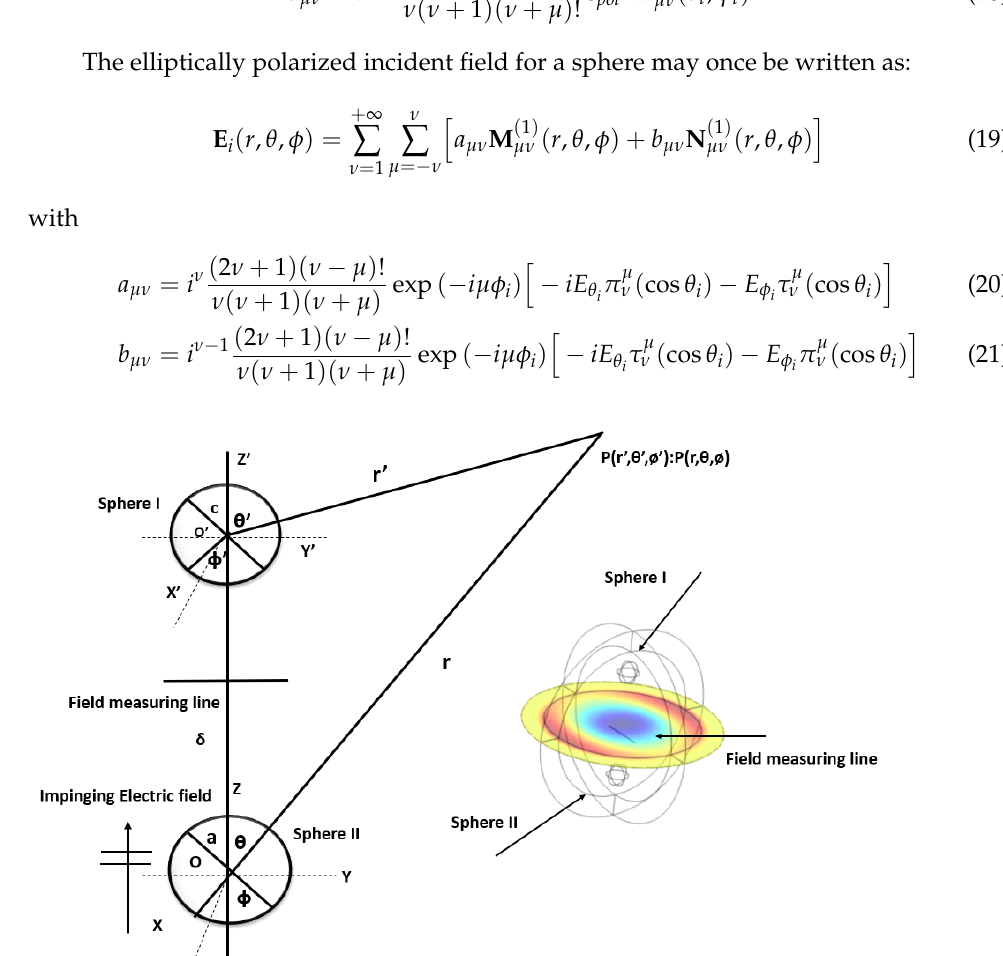
Figure 1. Geometry of the two PEC spheres exercising translation of the spheres along- z -axis using translation